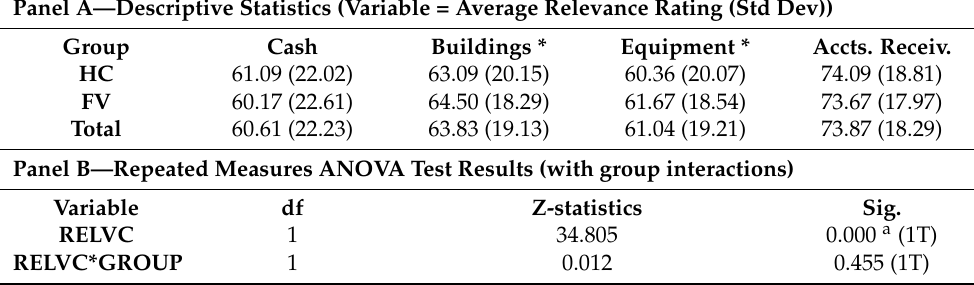
Table 5. Analysis of Relevance of Measurement